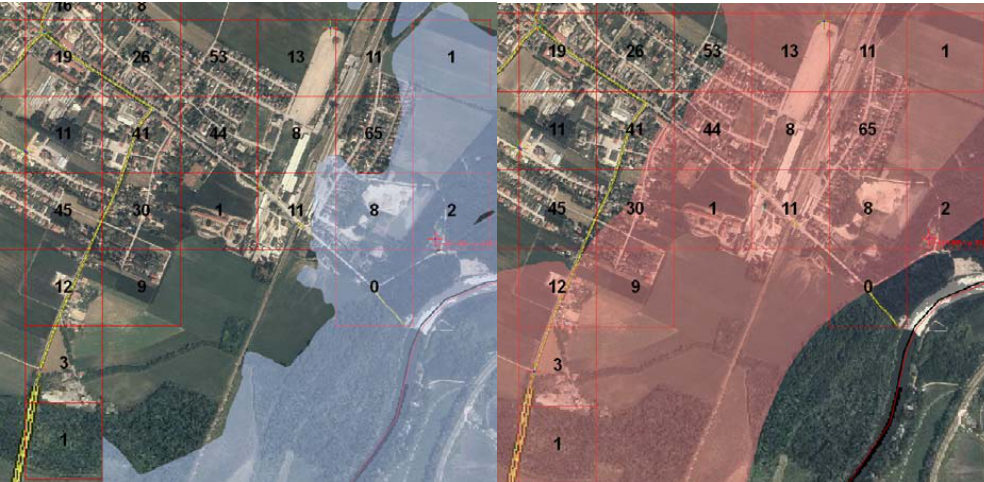
Figure 2: HORA200 risk zones (left hand side, blue area) and ex post water line modelling - Fig. 2. HORA HQ200 risk zones (left hand side, blue area) and ex post water line modelling – WAL zones (right hand side, red area) in the flooded area of D¨urnkrut. Data source: HORA – Hochwasserrisikozonierungssystem Austria and firm WAL zones (right hand side, red area) in the flooded area of Dürnkrut. Data source: HORA – Hochwasserrisikozonierungssystem Austria and firm RIOCOM.